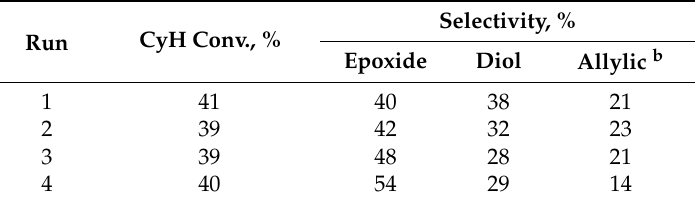
Figure 7. The hot catalyst filtration test for CyH oxidation with H 2 O 2 over MIL-125. Reaction conditions as in Table 1, entry 3. Table 4. The reuse of MIL-125-L in CyH oxidation with H 2 O 2 in the presence of 1 equivalent of HClO 4 a .